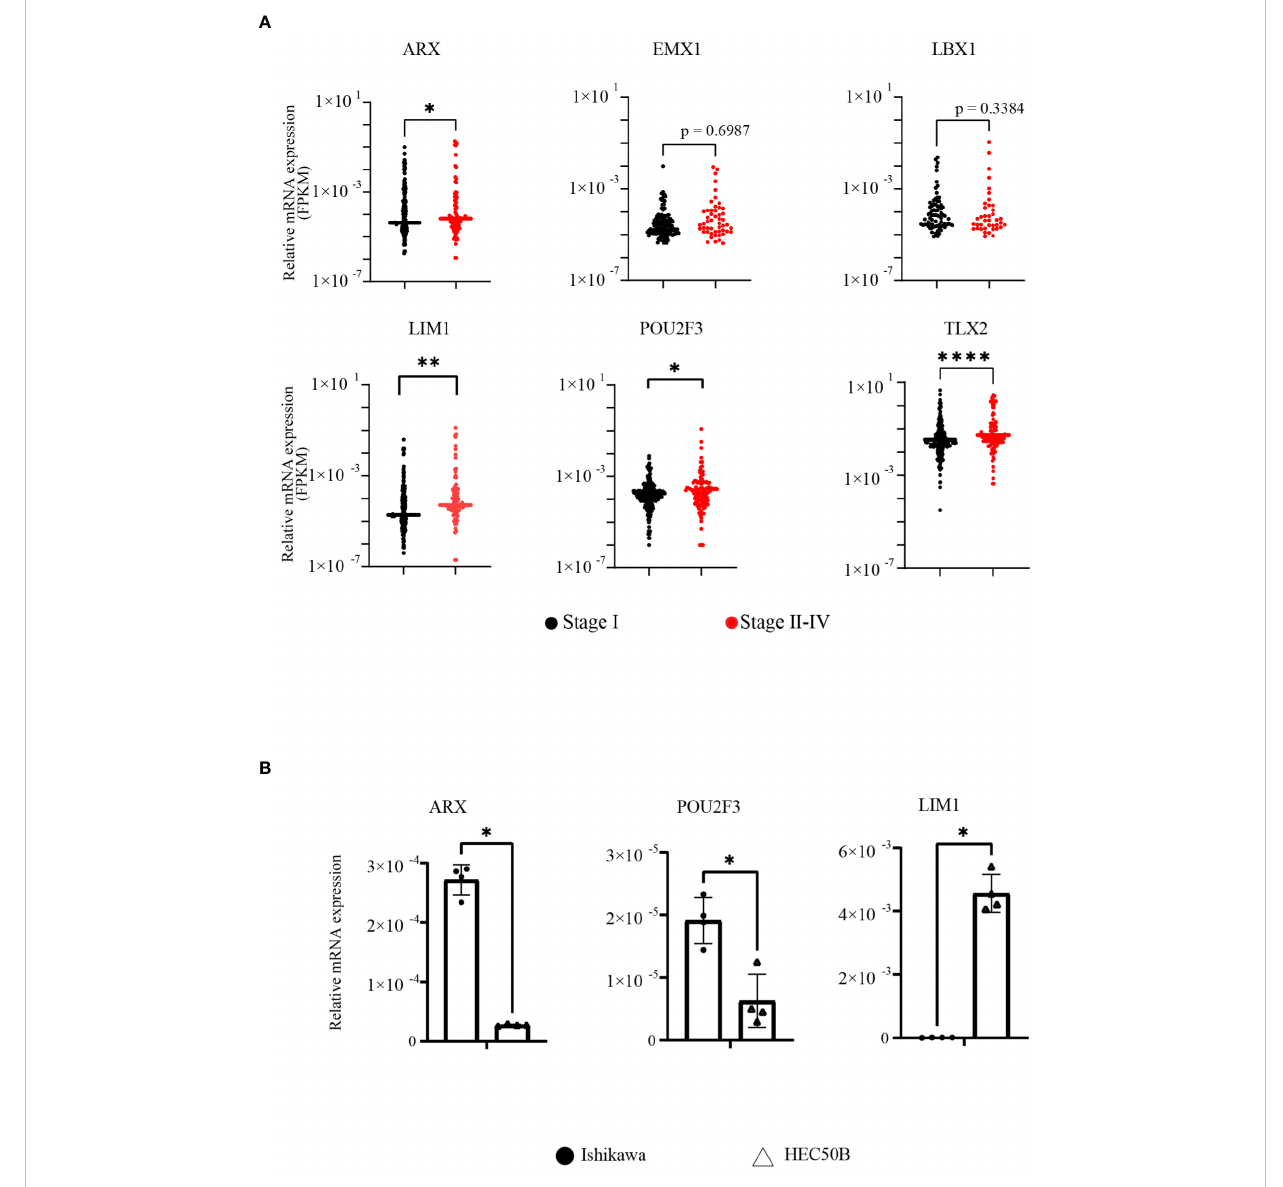
FIGURE 2 LIM1 was highly expressed in advanced EC and grade 3 EC cells. (A) Comparison of FPKM values between early- and advanced-stage EC groups in genes included in the HOMEOBOX group (stage I: n = 255, stages II – IV: n = 110, Mann-Whitney U -test). (B) Comparison of HOMEOBOX gene expression in EC cell lines by RT-qPCR. Ishikawa cells and HEC50B cells were derived from grade 1 and grade 3 disease, respectively (n = 3, Student ’ s t -test). * p < 0.05, ** p < 0.01, **** p < 0.0001. Graphs show means ± standard